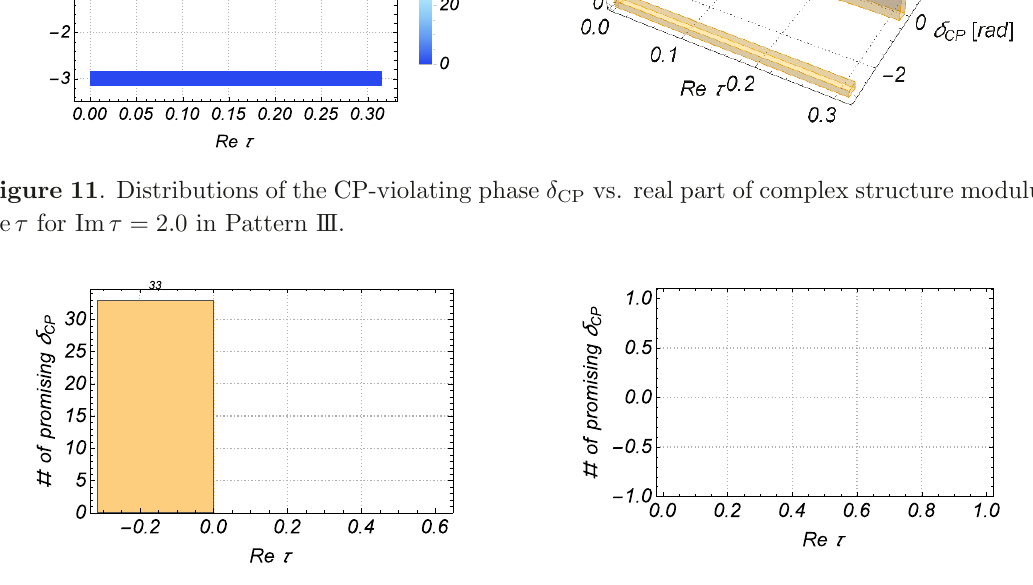
Figure 12 . Left panel: frequency of Re τ satisfying an inequality in eq. (4.8) for Im τ = 1 . 9 in Pattern III. Digits on the top of histogram bins denote the numbers of combinations of Higgs VEVs. Right panel: the same one for Im τ = 2 .